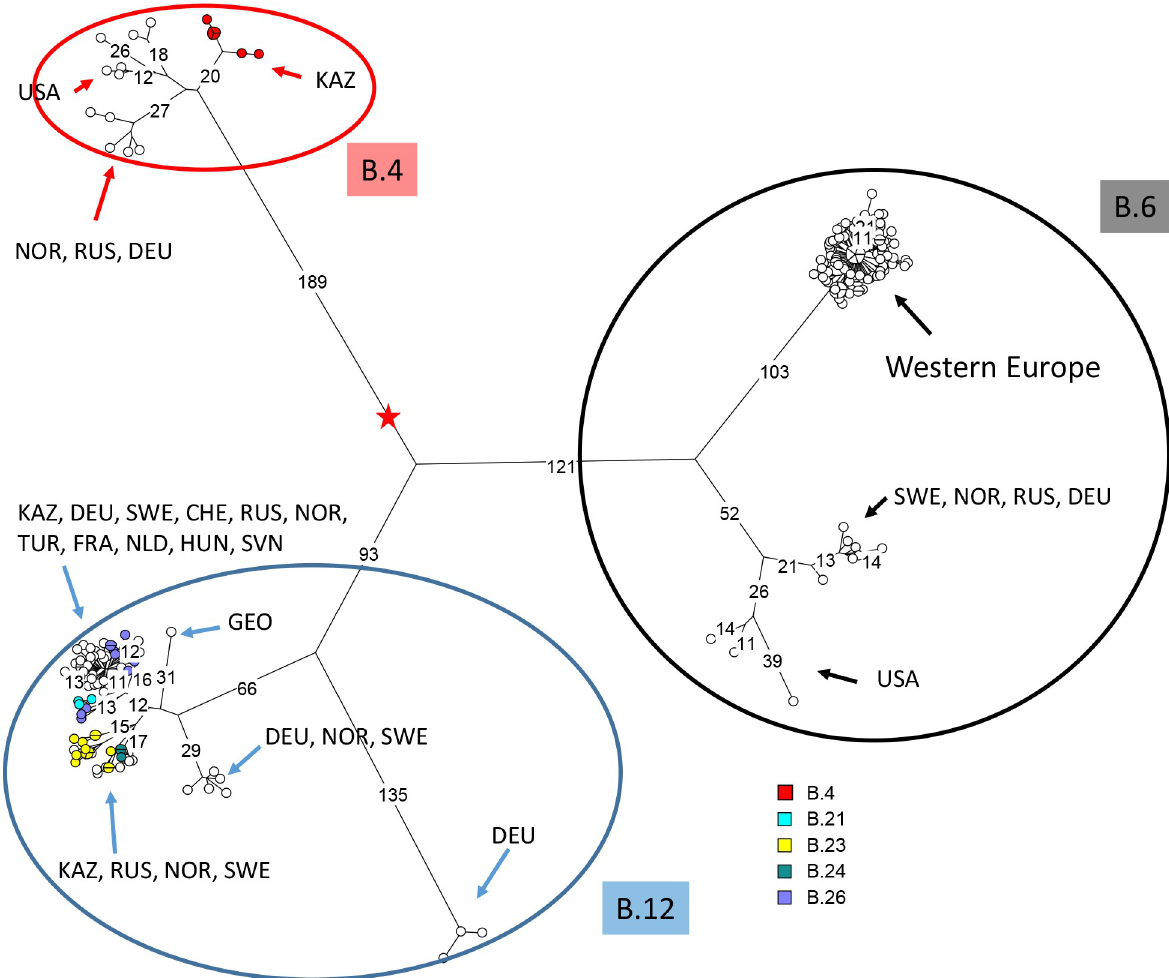
Fig 1. Positioning the Kazakhstan strains within the holarctica subspecies by wgSNP and Maximum Parsimony analysis. Two thousand and twenty-two SNPs were called among 219 strains comprising 39 strains from Kazakhstan and 180 public data sets belonging to holarctica B.4, B.6 or B.12 (B.16 alias japonica strains were used to root the tree and are not shown). The red star shows the position of the MRCA. Branch lengths of more than ten SNPs are indicated. The branch scale is linear. The total tree size is 2034 (homoplasia 0.6%). The circles representing strains from Kazakhstan are colored according to canSNP assignment as indicated. The geographic origin of strains constituting secondary sublineages is indicated using three-letters country codes.